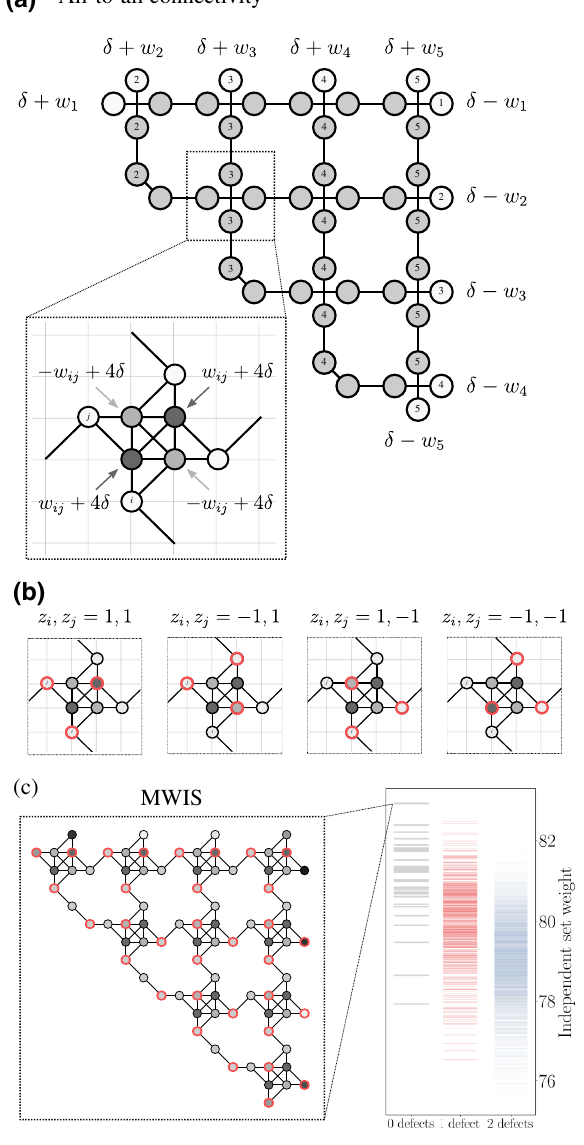
FIG. 7. Example encoding procedure for the QUBO and Ising problem for a 5-bit system. (a) Crossing lattice. Similar to the MWIS mapping, we can construct the UDG-MWIS represen- tation of a generic QUBO problem by inserting a gadget at each crossing. The gadget has a similar structure as the crossing gadget used in the MWIS encoding, but the weights on the ancil- lary vertices are biased to induce quadratic interaction terms w ij between the effective degrees of freedom; see (b). (c) Example of an encoded N = 5 QUBO problem, and the high-weight spec- trum of the encoded cost function, illustrating that the MWIS is indeed in the 0-defect sector and thus encodes the solution of the QUBO problem. The QUBO solution {− 1, + 1, + 1, + 1, + 1 } is encoded in the boundary of the